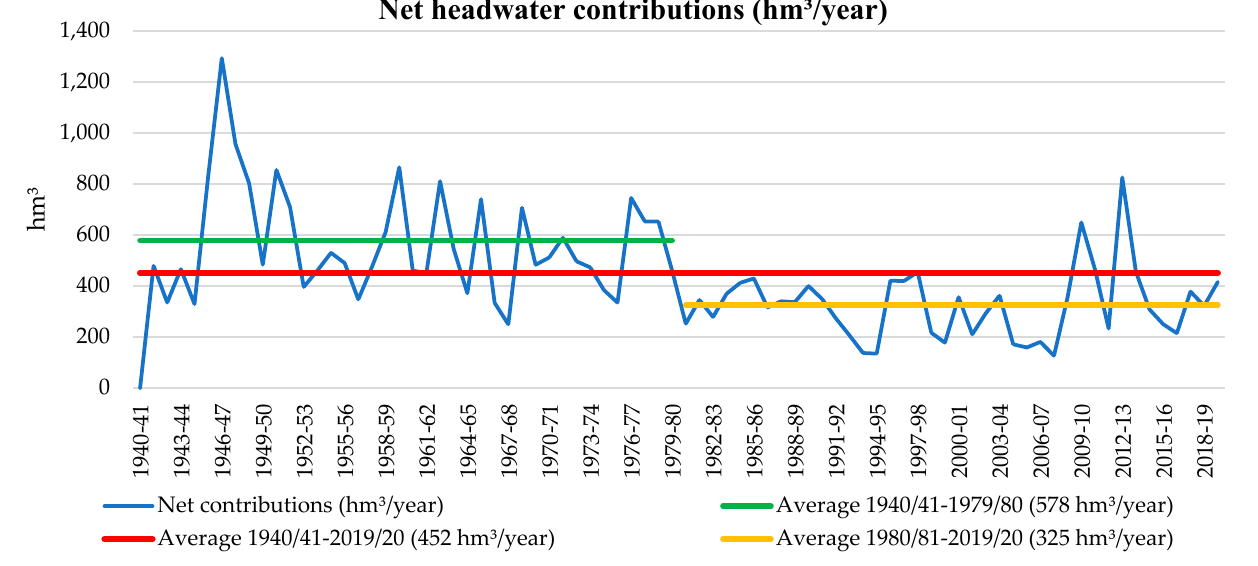
Figure 2. Net contributions regulated in the headwater reservoirs of the SRB. Period 1940/41–2019/20. Source: own elaboration based on [49].